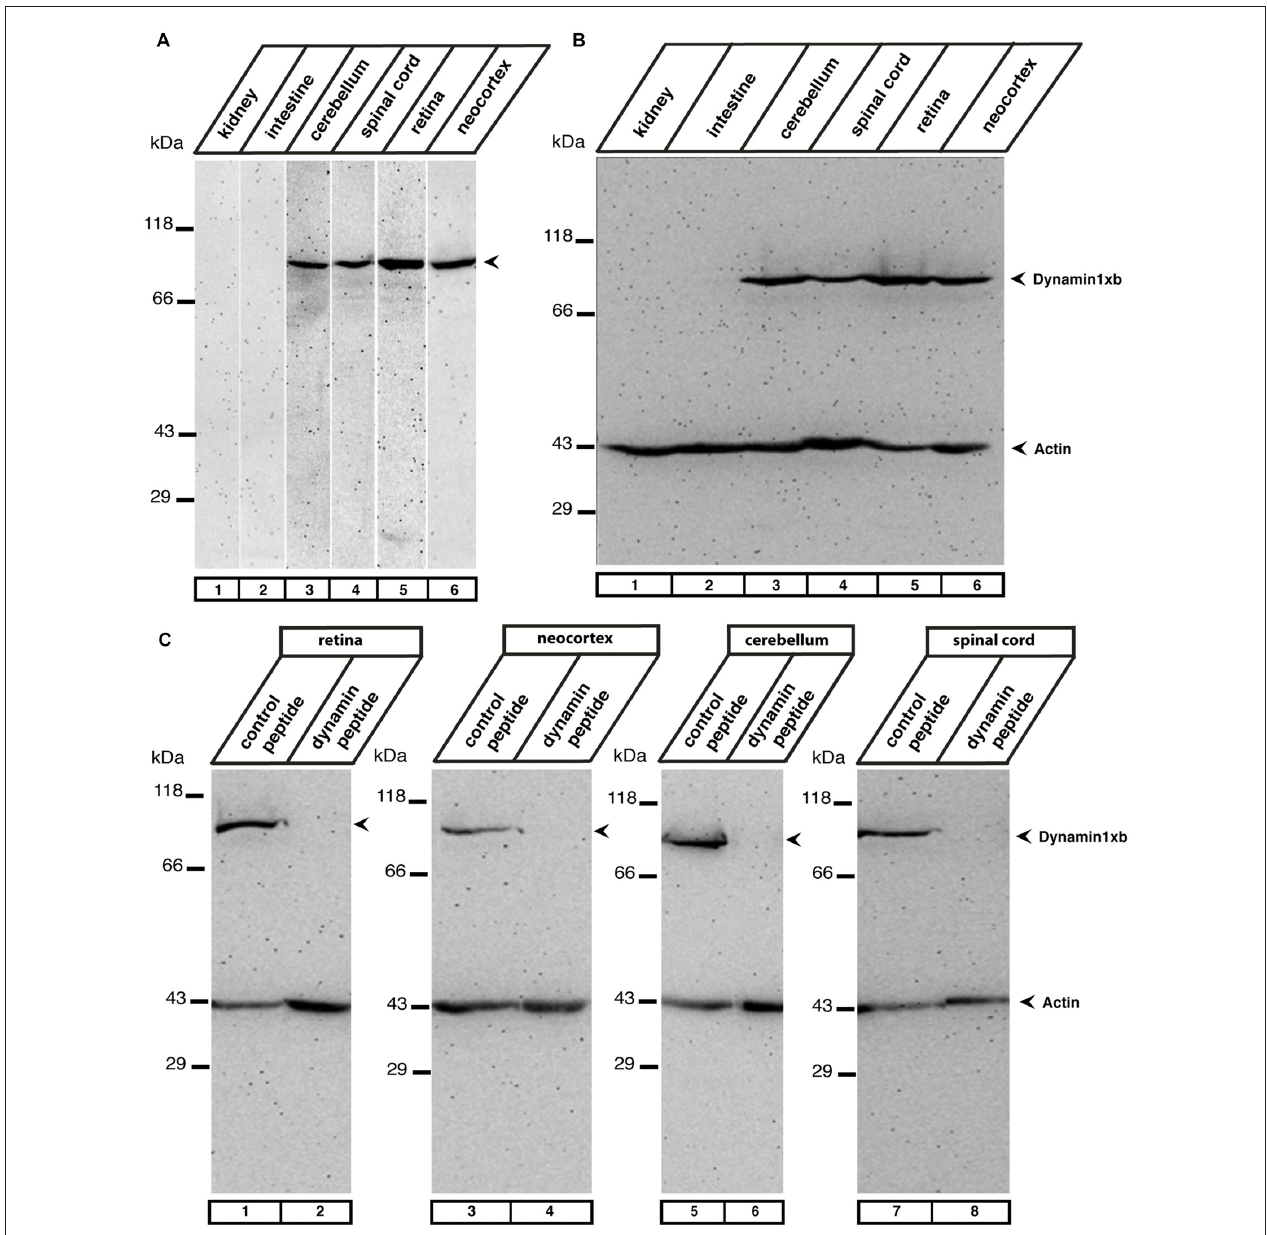
FIGURE 2 | (A) The indicated mouse tissues were tested for the presence of dynamin1xb with the characterized monoclonal antibody 1E10 by western blot analyses. We observed a single band at the expected running position of ≈ 100 kDa in neuronal tissues (cerebellum, retina, spinal cord, neocortex, lanes 3–6) but not in extra-neuronal tissues (kidney, intestine; lanes 1,2). In (B) the same tissue extracts as in (A) were loaded and tested subsequently with the dynamin1xb antibody and a monoclonal antibody against actin, that served as a loading control. Similar as in (A) , dynamin1xb was only present in the neuronal tissues whereas the actin immunosignal was present in all tissues at ≈ 43 kDa. (C) The specificity of the dynamin1xb immunolabeling was further corroborated by blocking experiments. The ≈ 100 kDa band disappeared if the dynamin1xb was pre-absorbed with the dynamin1xb “PP12” peptide (lanes 2,4,6,8) but was unaffected if the antibody was pre-absorbed with an unrelated peptide (lanes 1,3,5,7). Immunodetection of actin at ≈ 43 kDa served as a loading control.